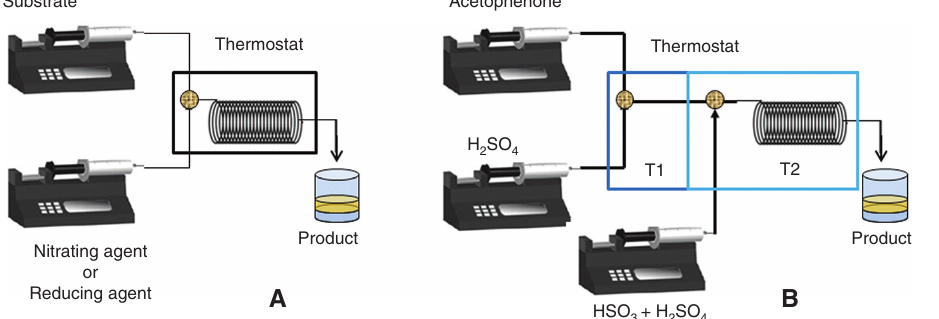
Figure 1 Schematic of the experimental set-up. (A) Nitration of organic substrate 1 with nitrating agent or reduction of the nitro aromatic 2 with the reducing agent. (B) Mixing of 1 with sulfuric acid followed by nitration with nitrating